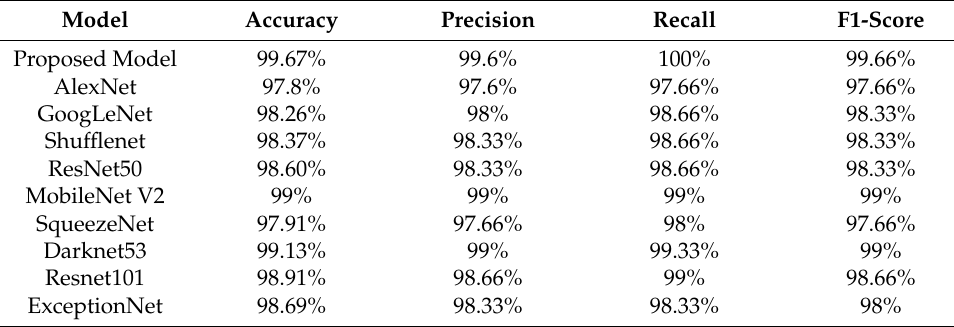
Table 5. Experimentation results of pretrained models.